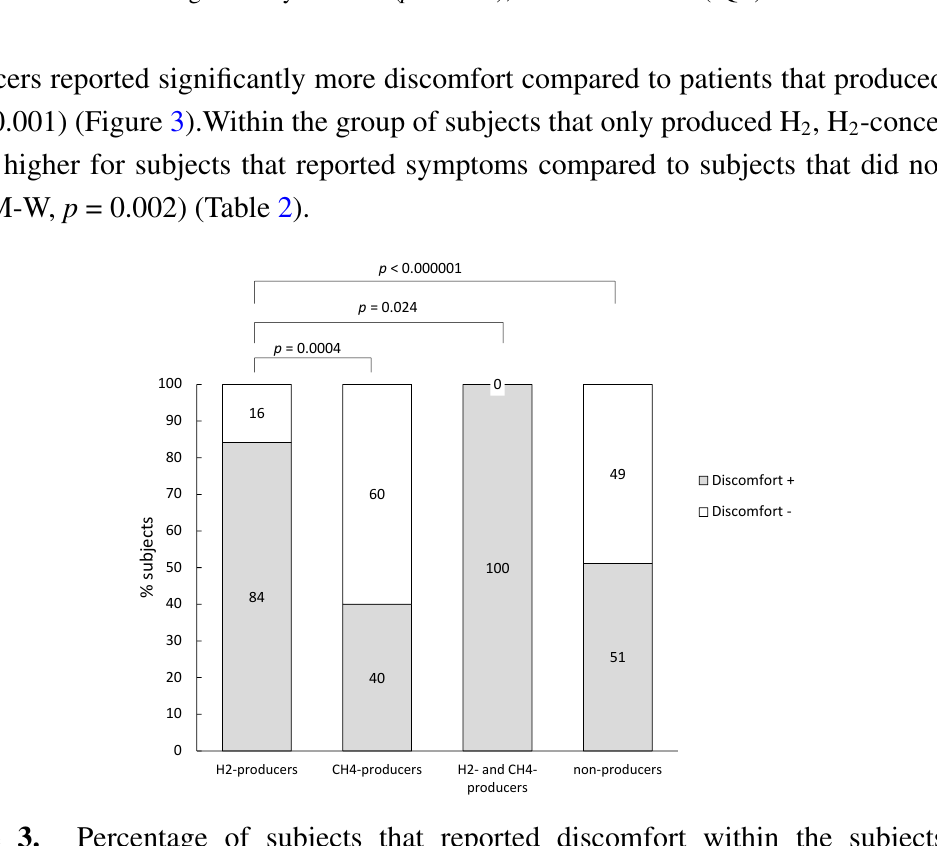
Figure 3. Percentage of subjects that reported discomfort within the subjects with lactase deficiency.